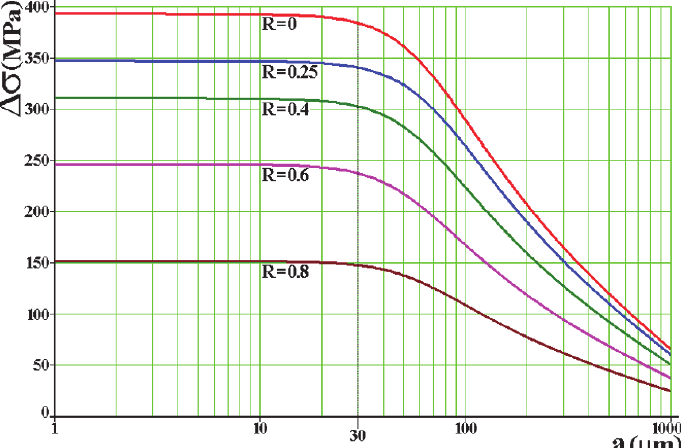
Figure 2: Larger stress ranges  tolerable by the studied component under many R –ratios as a function of the size a of an edge crack, for w = 3.4mm , h = 1.12 ,  K th0  6MPa  m , a 0  59mm ,  6 , and  F  1.6 .